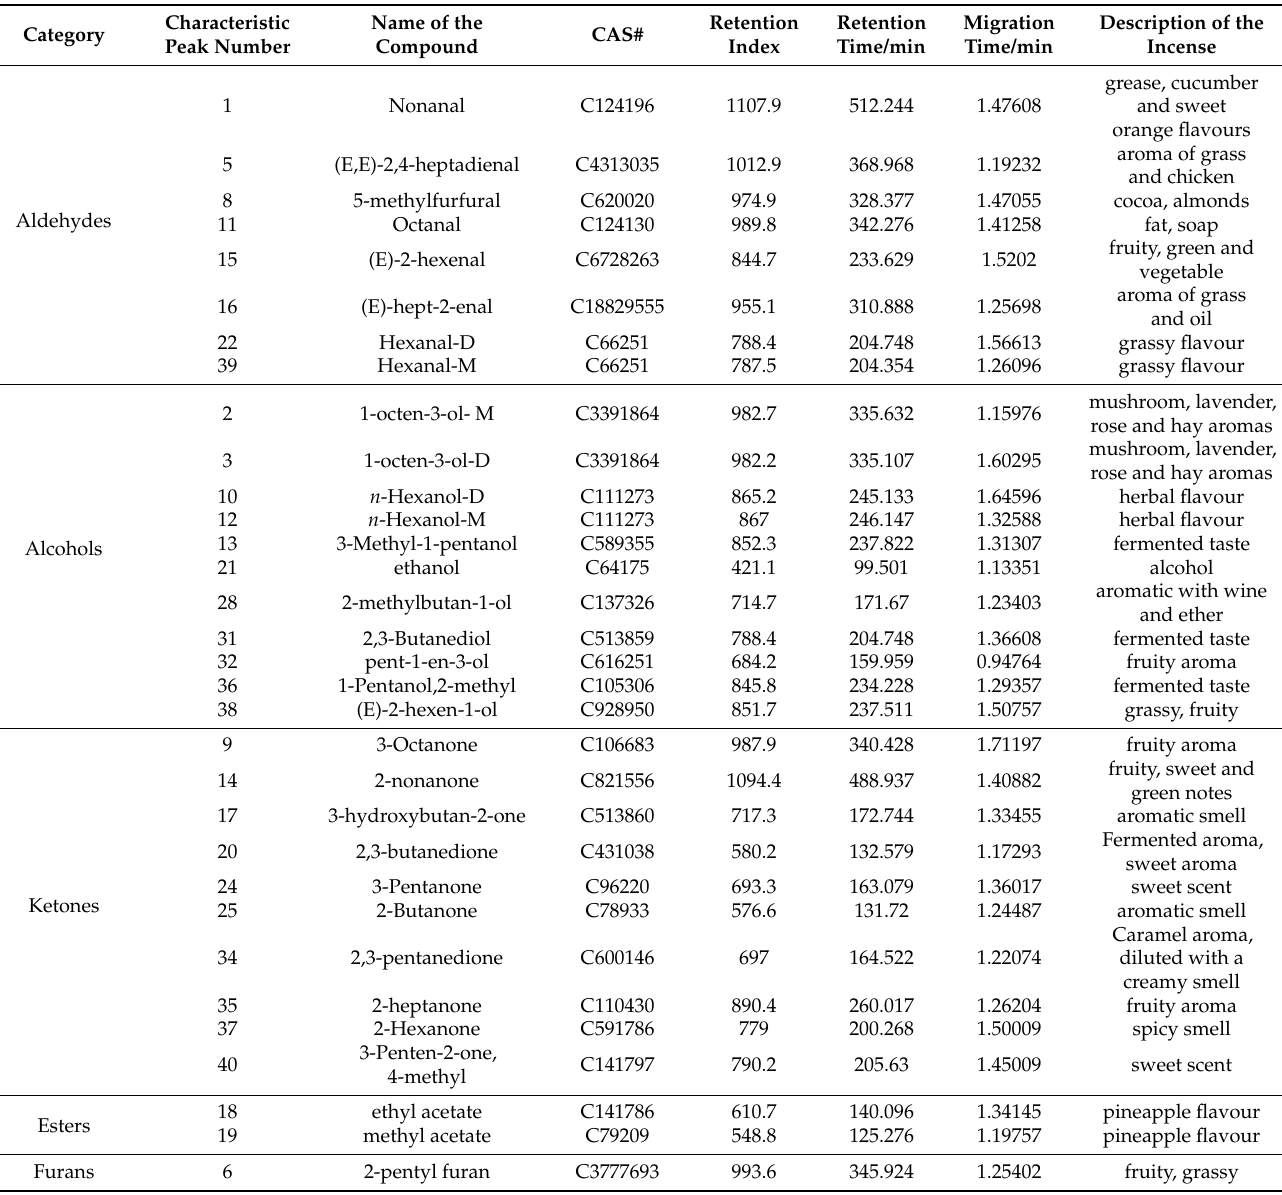
Table 4. Volatile organic compounds were identified from crucian carp muscle, after treatment with